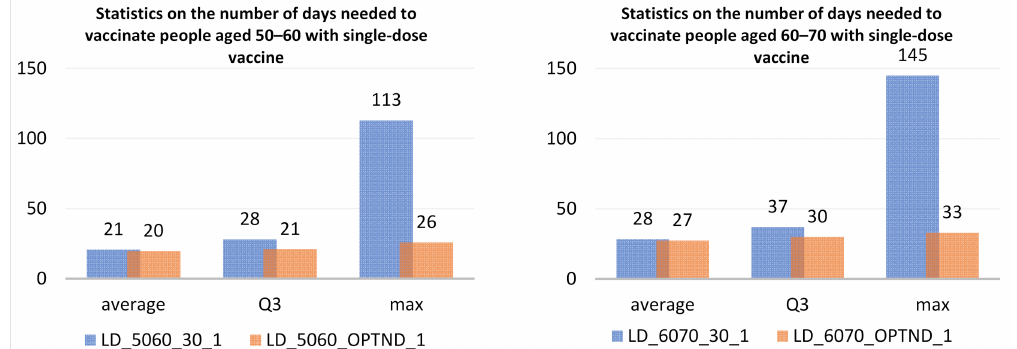
Figure 15. Statistics on the number of days at all vaccination sites in the simulations LD_5060_30_1, LD_5060_OPTND_1, LD_6070_30_1,